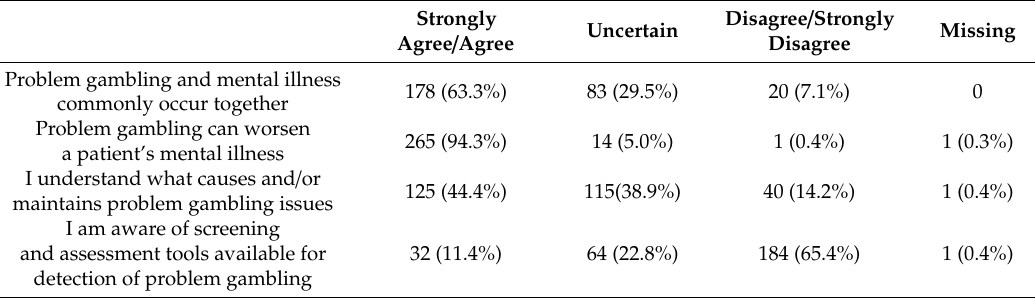
Table 2. Self-reported knowledge of gambling ( n =